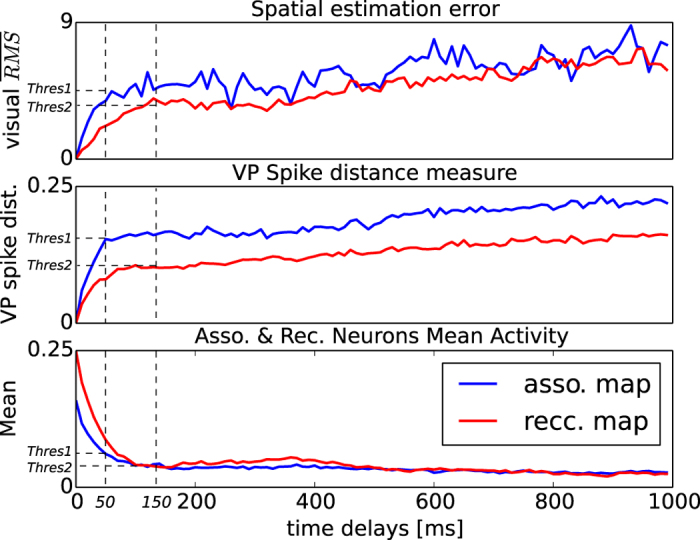
Average neural activity of the associative and recurrent maps with respect to visual delays and for spatially congruent visuo-tactile signals (bottom), temporal spike precision relative to visual delays added with the VP distance (middle), and visual spatial error with respect to delays (top). For the three plots, the activity level quadratically decreases for visual delays less than 150 ms. This interval corresponds to the sensitivity of the neurons within their RF, for which the rec. map is more robust than the asso. map to cancel out the effect of delays with lower spatio-temporal error and with less variability (middle and top charts). The asso. map, which is more sensitive than the rec. map, has an amplitude level less than 50 ms. With a delay longer than 150 ms, the neurons of the two maps linearly decay.